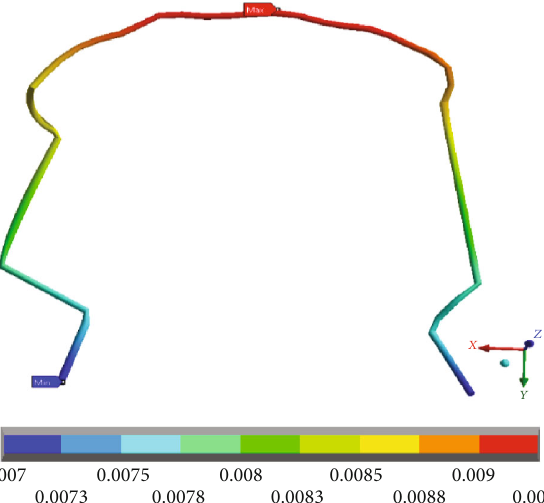
Figure 12: Total deformation that occurs in the wire. The red marker indicates the maximum deformations, and the blue marker indicates the minor